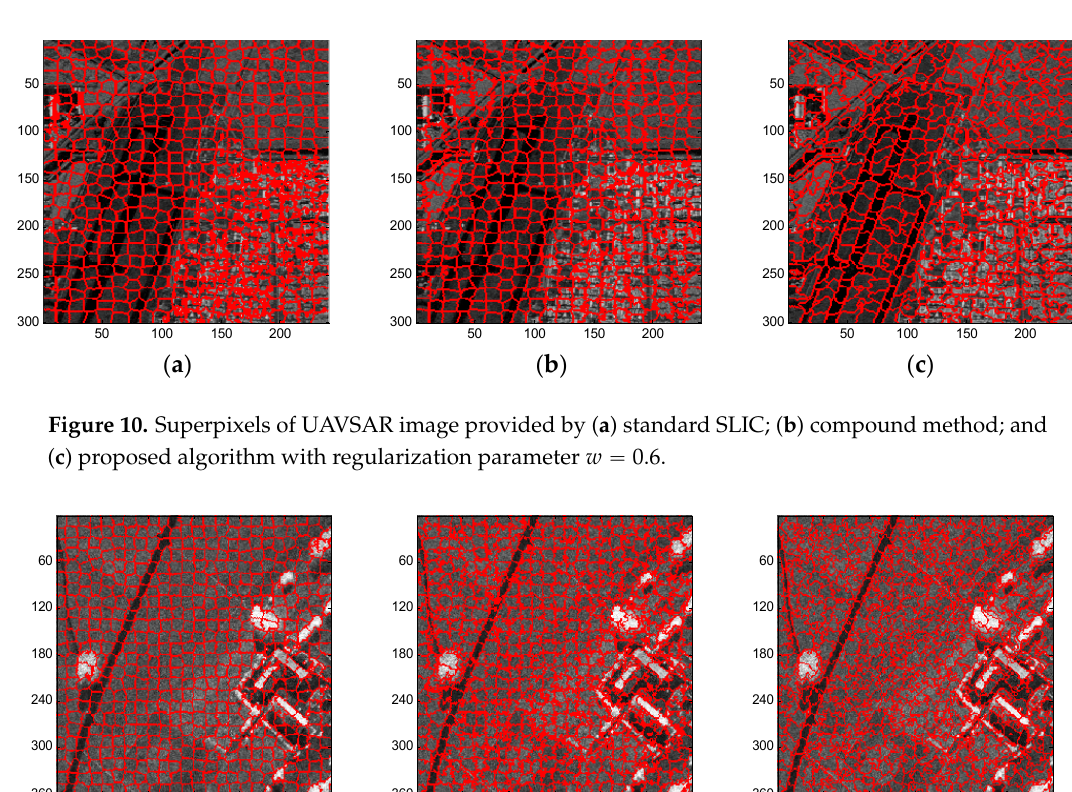
Figure 11. Superpixels of F-SAR image provided by ( a ) standard SLIC; ( b ) compound method; and ( c ) proposed algorithm with regularization parameter 0.6 w .